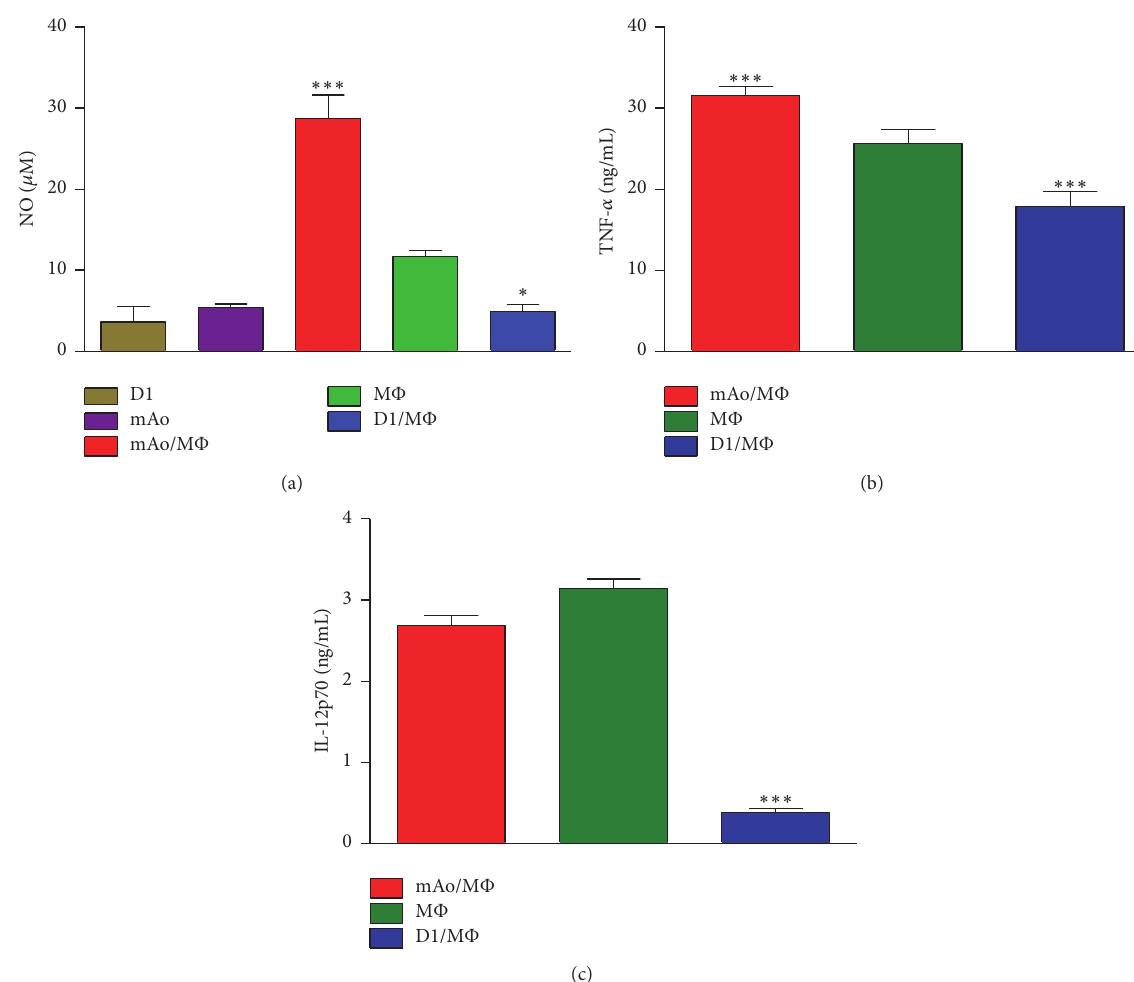
Figure 1: When in coculture with M Φ , aortic mesenchymal progenitor cells, mAo, enhance while bone marrow-derived mesenchymal progenitor cells, D1, suppress LPS-induced NO, TNF- 𝛼 , and IL-12p70 production. Nitrite production as a measure of NO (a), TNF- 𝛼 (b), and IL-12p70 (c) was measured in culture supernatants of mAo MSC, D1 MSC, and M Φ cultured alone and in coculture. Cultures were treated with LPS (100ng/mL) for 17 hr. Data are presented as mean ± SEM and are representative of 3 experiments each with 𝑛 = 4 . ∗ Significantly different from M Φ alone, 𝑃 < 0.05 , ∗∗∗ significantly different from M Φ alone, 𝑃 < 0.0001 .